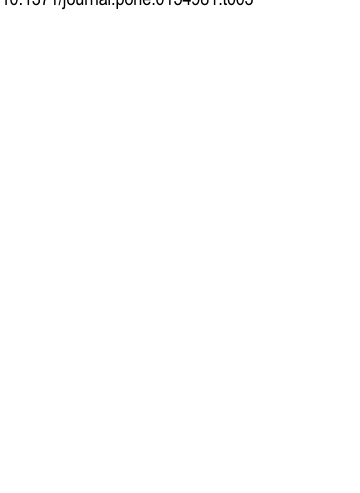
nitrogens. Azoxy compounds presumably would arise from condensation of phenylhydroxyla- mine and nitroso groups. The peak at 338 ppm was also observed in SRNOM reacted with sodium nitrate in the presence of unfiltered UV irradiation [6]. Peaks corresponding to nitriles, from Beckmann fragmentations of ketoximes and quinone monoximes, are present at 255, 251, and 253 ppm in the SRNOM, SRFA and PFA, respectively (Fig 1). Primary amides, from 90 to 120 ppm, with peak maxima at 106 ppm, are present in all three spectra and result from Beckmann fragmentations of ketoximes or Beckmann rearrange- ments of aldoximes (Fig 2). The assignment of the peaks at 168 ppm is uncertain. In 15 N NMR spectra of NOM samples reacted with hydroxylamine, the peaks can be attributed to hydroxa- mic acids, from nucleophilic substitution of esters by hydroxylamine. Peaks corresponding to ammonium not removed in the dialysis are present at 23 ppm in the SRNOM and 22 ppm in the SRFA and PFA. Considering the acidic conditions of the nitric acid treatment, hydrolysis of secondary reaction products such as nitriles and primary amides is likely the predominant